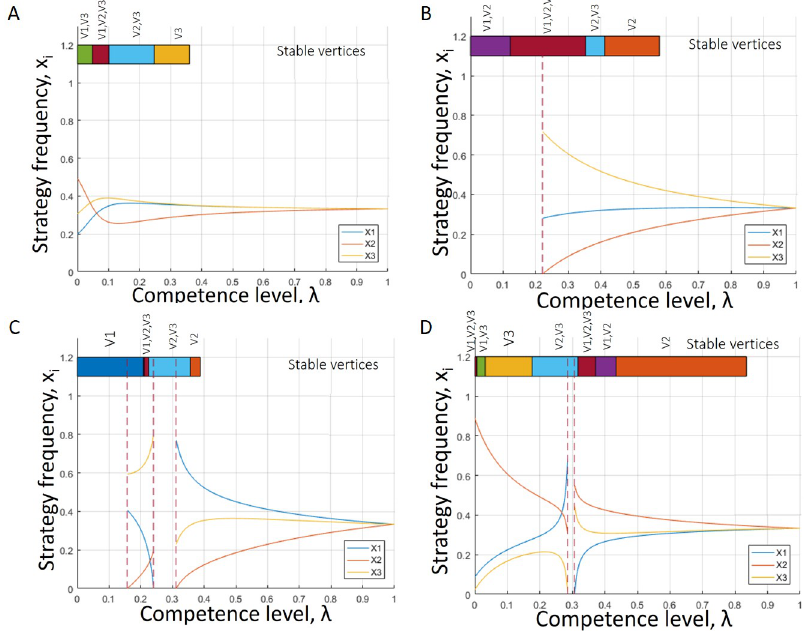
Fig 4. Various game transitions of the unstable RPS game as λ varies between [0, 1]. The components of the interior fixed point are plotted as functions of λ . Further, the coloured bar at the top of the plot indicates stability intervals of λ for different vertices (a stable vertex is indicated on top of the bar). (A) The interior fixed point exists for all λ but vertices interchange their stability. In the limit of mistakes ( λ ! 0), two vertices are stable. (B) The interior fixed point exists for a sub-interval and vertices interchange their stability. As λ ! 0, two vertices are stable. (C) The interior fixed point exists for two sub-intervals of (0, 1). In the limit of mistakes ( λ ! 0), only vertex 1 is stable. (D) The interior fixed point exists for almost all values of λ . In the limit of mistakes ( λ ! 0), all three vertices are stable. Generally, the exact equilibria transitions and existence of an interior equilibrium is determined by the limiting distribution of mistakes, S . We found that for almost all matrices S there is a high chance that at least one of the pure strategies will become dominant.